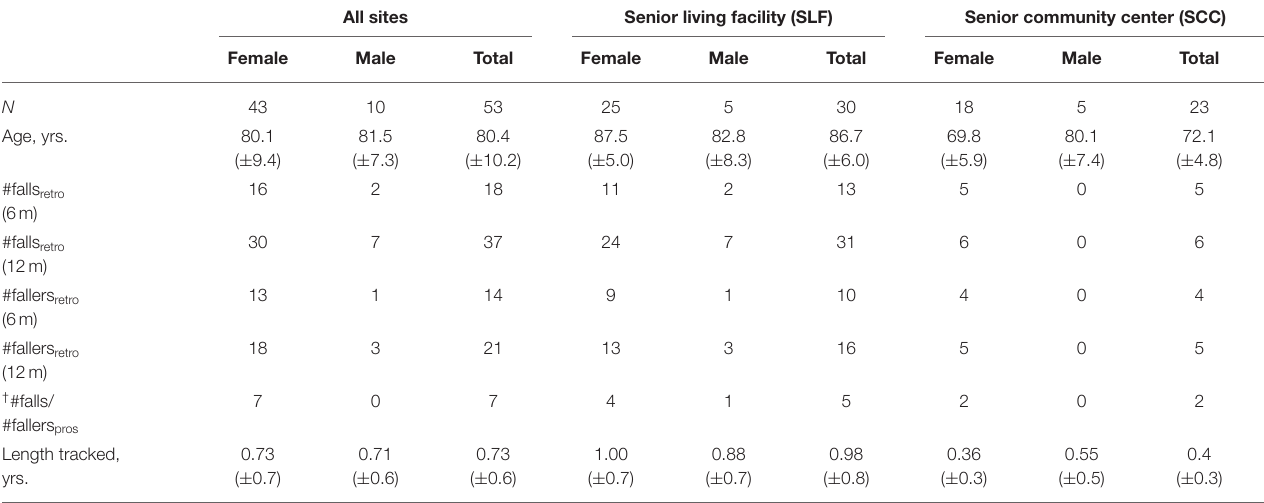
TABLE 1 | Demographics (mean ± SD) and fall events of the participants tracked, stratified by location. All